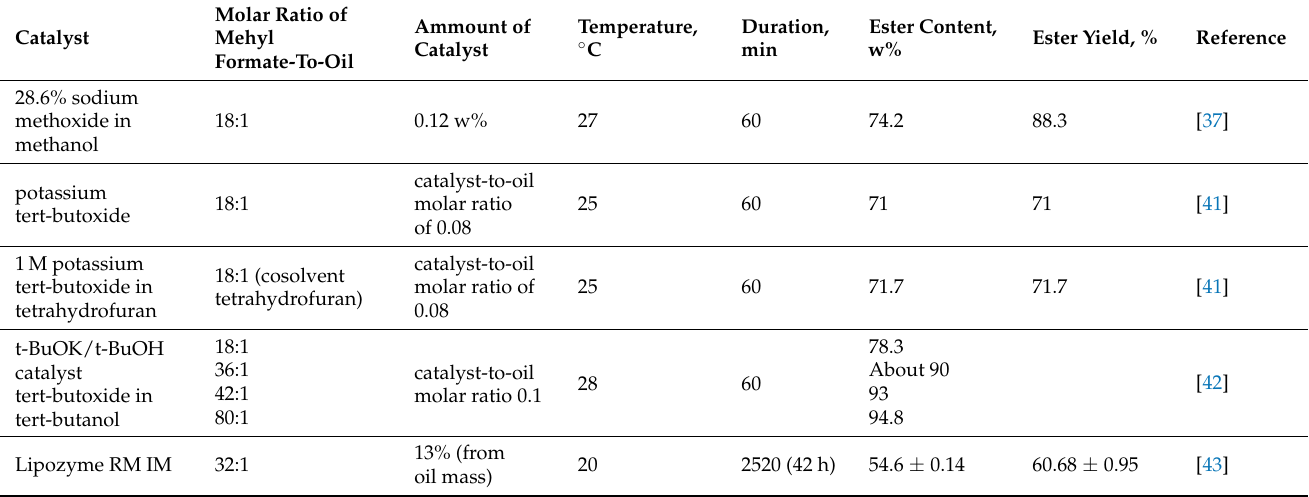
Table 1. Summary of studies on using methyl formate for interesterification of rapeseed